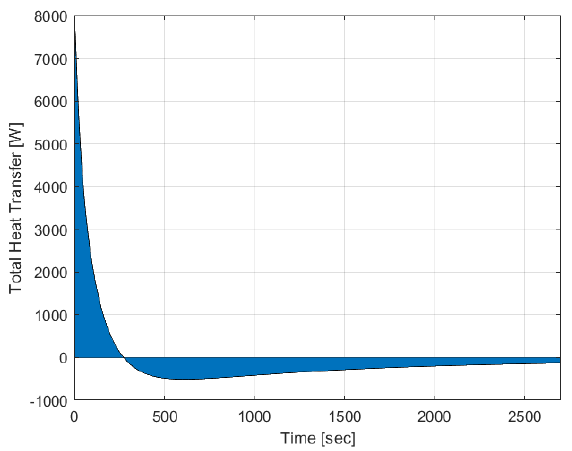
Fig. 21. Total heat transfer on outer tube